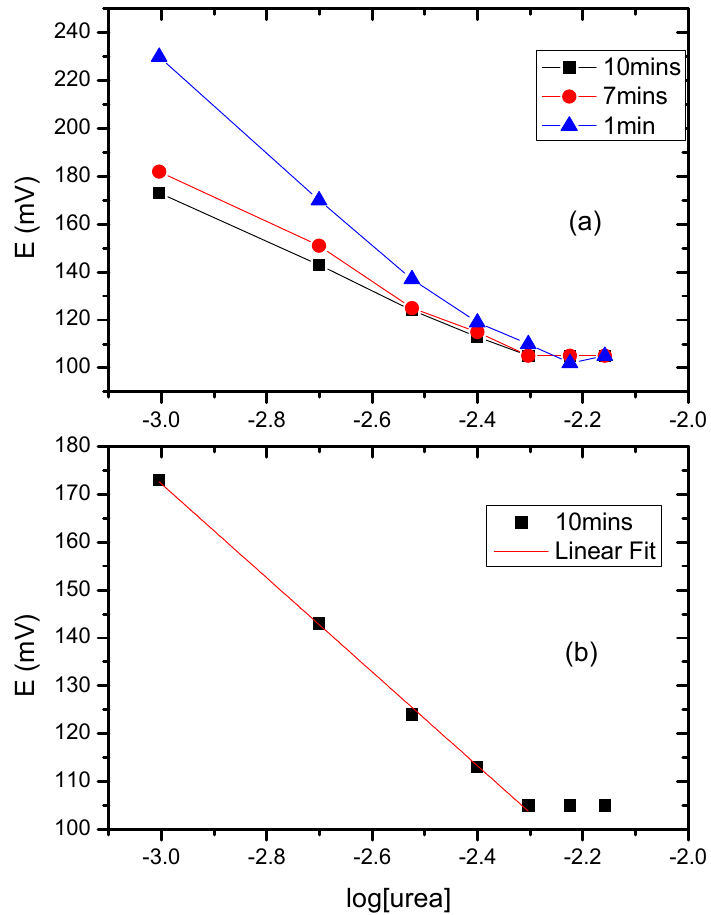
Figure 8. ( a ) Graph of electrode potential (w.r.t. Ag/AgCl) against log[urea] for several different delays from the moment of addition of urea; ( b ) Equilibrated data for the 10-min delay, showing linear fit in the region 1–5 mM.